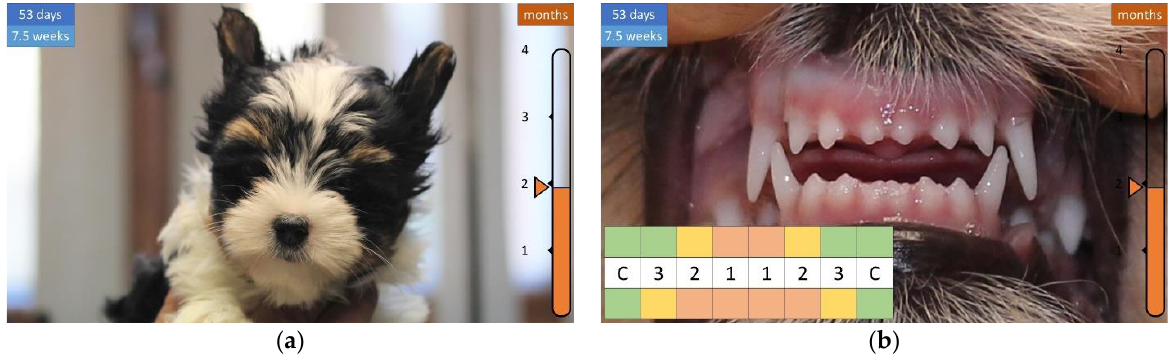
Figure 7. Development of the skull and teeth in a 7.5-week-old puppy. ( a ) An elongated face begins to form. ( b ) All teeth are visible.